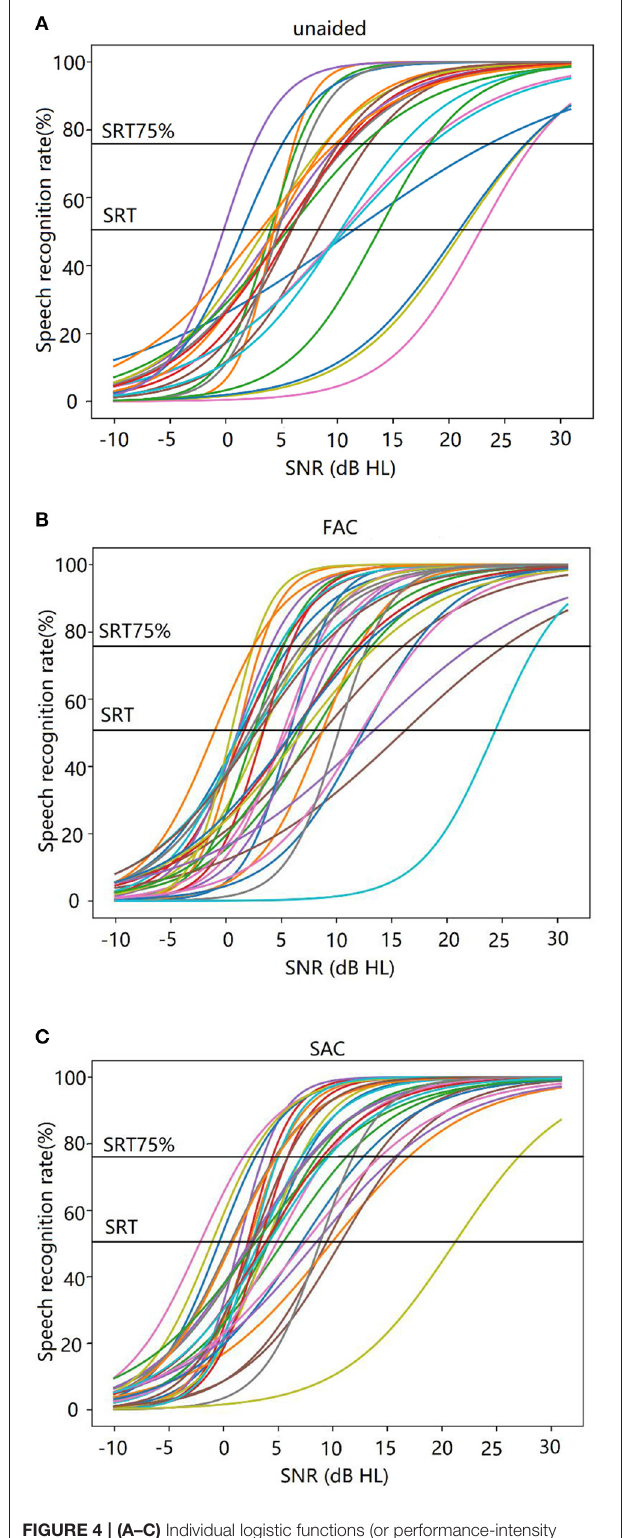
FIGURE 4 | (A–C) Individual logistic functions (or performance-intensity functions) estimated across signal-to-noise ratios. (A) Unaided, (B) FAC, and (C)